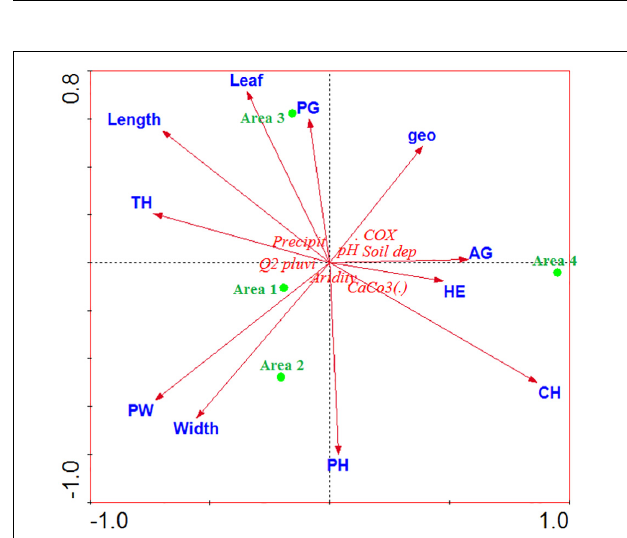
FIGURE 5 | Analysis of the main components of ecological parameters, vegetation and morphometry; AG, annual grasses; PW, perennial woody; PG, perennial grasses; PH, phanerophytes; TH, therophytes; geo, geophytes; HE, hemicryptophytes; CH,